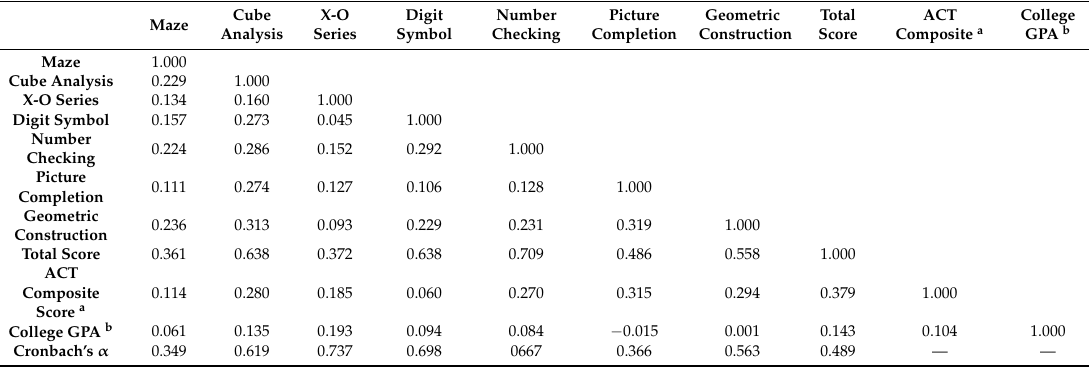
Table 3. Correlation Matrix of Army Beta Subtests Scores and Total Score ( n = 205).